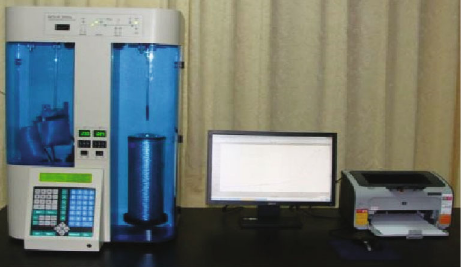
Figure 4: NOVA-1000 high-speed speci fi c surface area and aperture